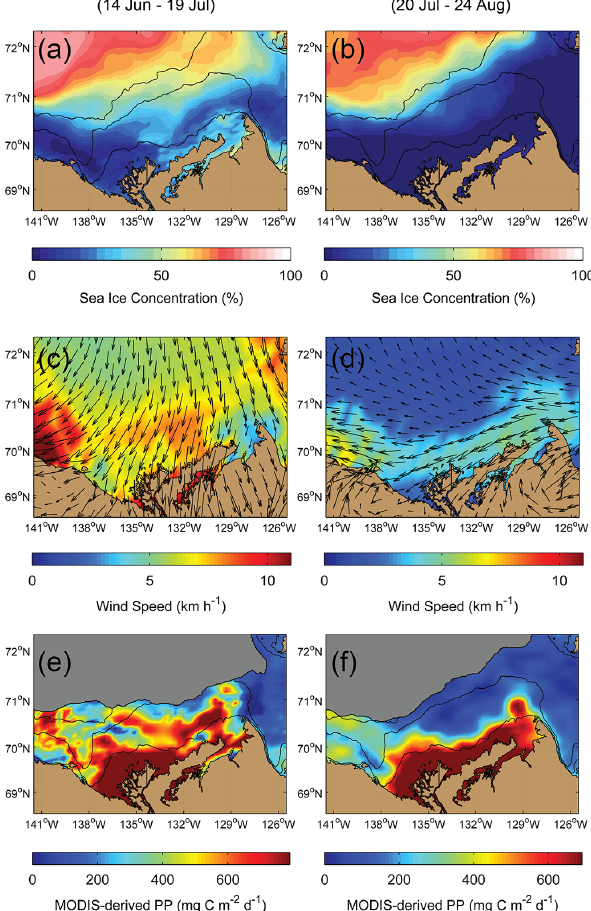
Figure 3. Composites of (a, b) sea ice concentration (% ice cov- erage) from the SSM/I-DMSP orbiting sensor, (c, d) wind velocity and vectors from the NCEP-NARR reanalysis, and (e, f) rates of primary production (PP) derived from the MODIS satellite, as aver- aged for the 35-day period just before (14 June–19 July, left panels) and just during (20 July–24 August, right panels) the ArcticNet– Malina field campaign. The grayscale masks in panels (e, f) depict the areas where no satellite pixels could be extracted from the dis- crete MODIS images because of the presence of sea ice. Bathymet- ric contours are 20, 100 and